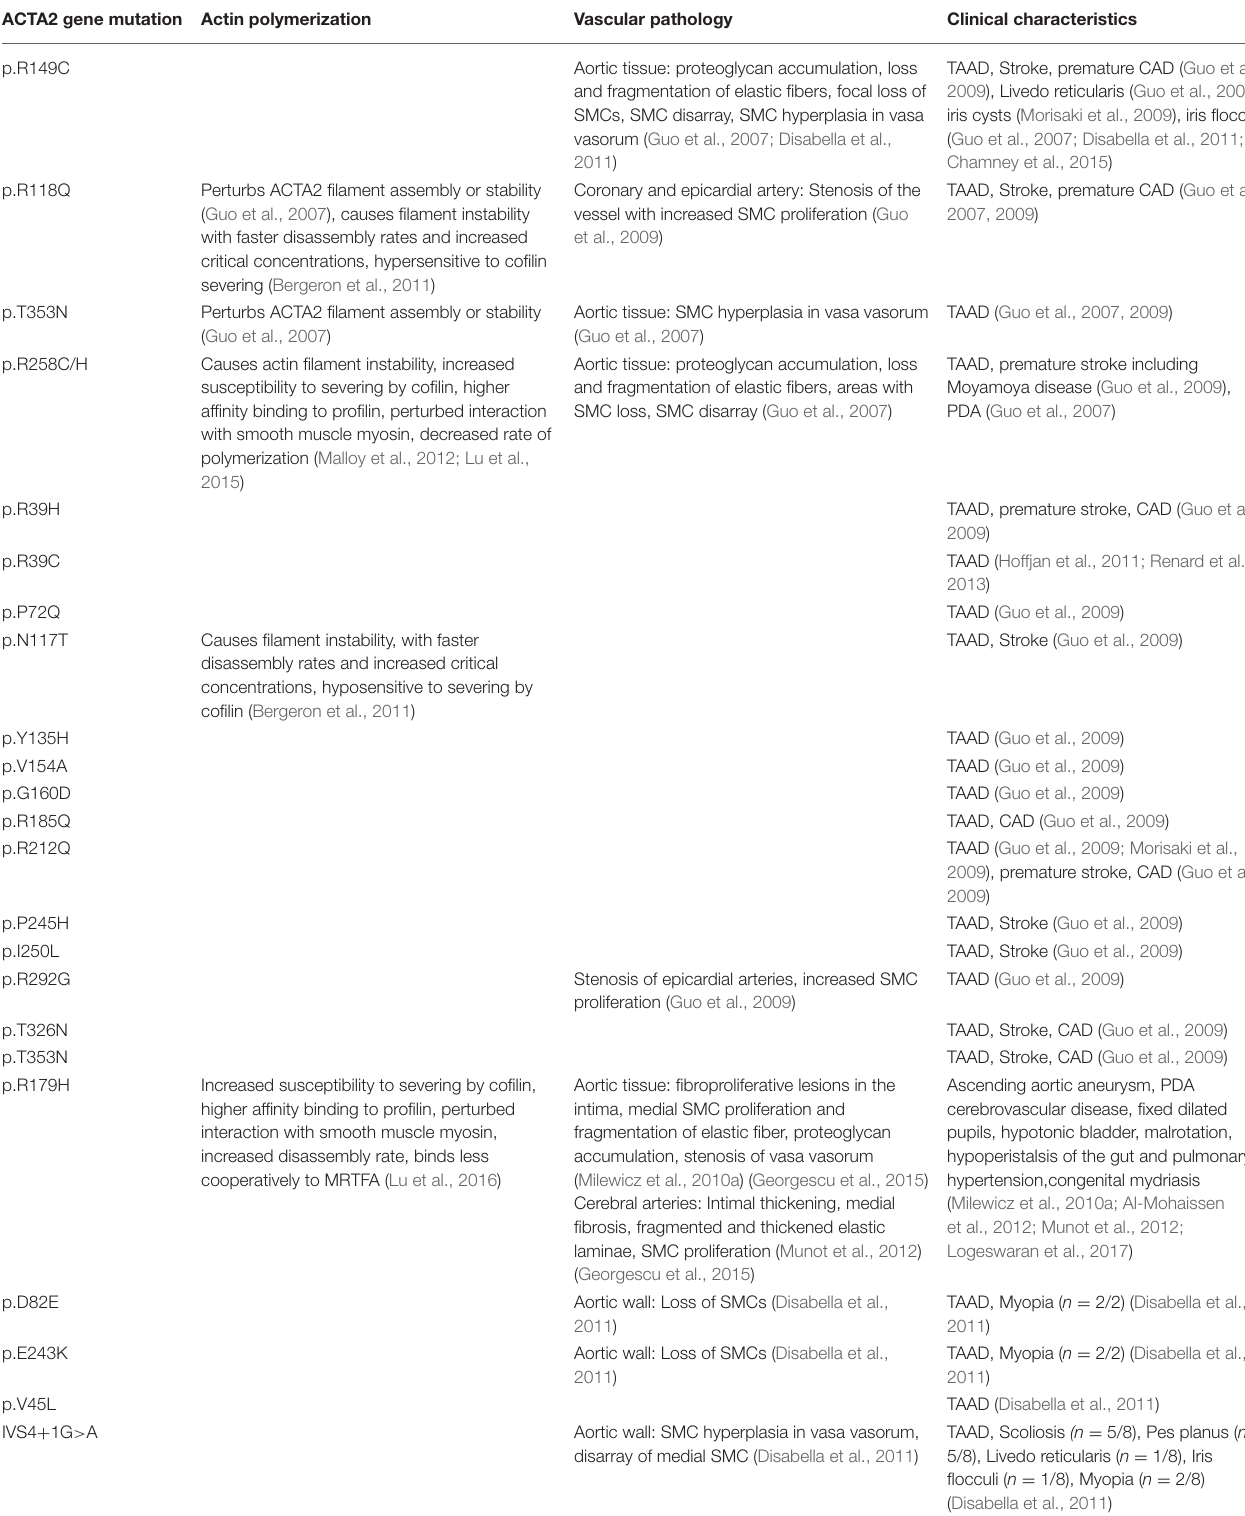
TABLE 1 | List of identified ACTA2 mutations with clinical and pathological